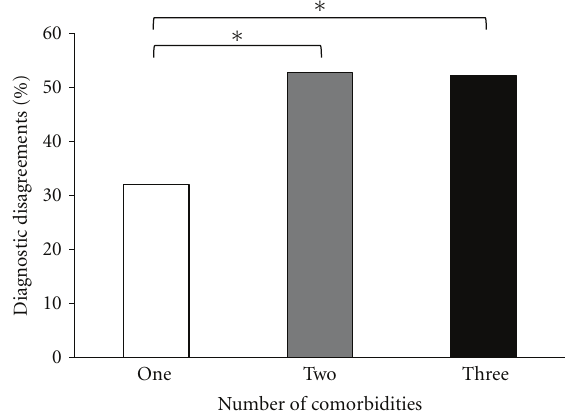
Figure 3: Percentage of diagnostic disagreements between the “pre- gold standard” diagnosis and the “gold standard” diagnosis by the type of the last episode experienced. ∗∗ P < 0 .